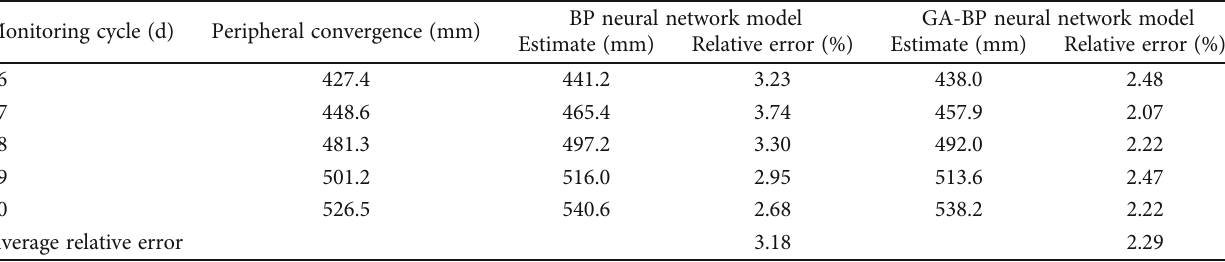
Table 2: Forecast results of the previous period.